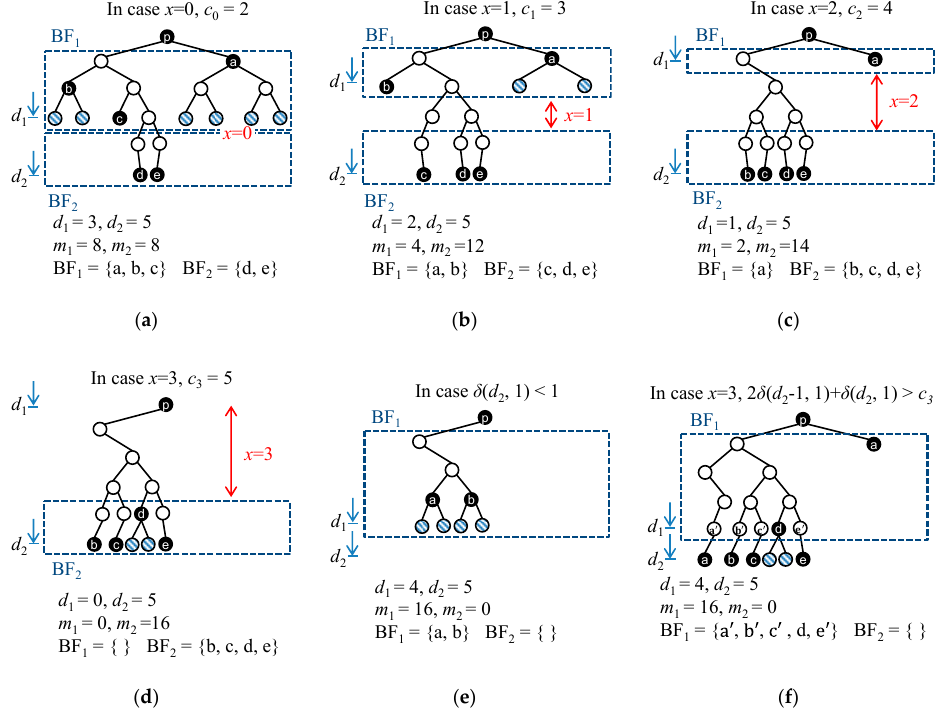
Figure 8. Examples of various sizes of BF 1 and BF 2 : ( a – f ) cases.